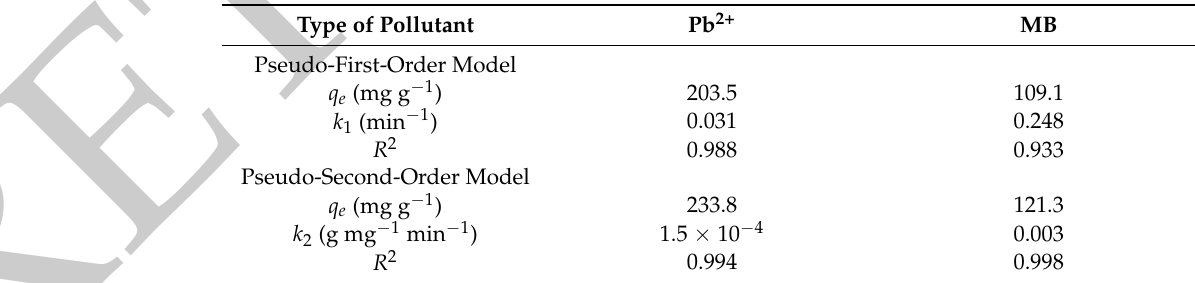
Table 1. Kinetic constants of the adsorbents for Pb 2+ and MB.